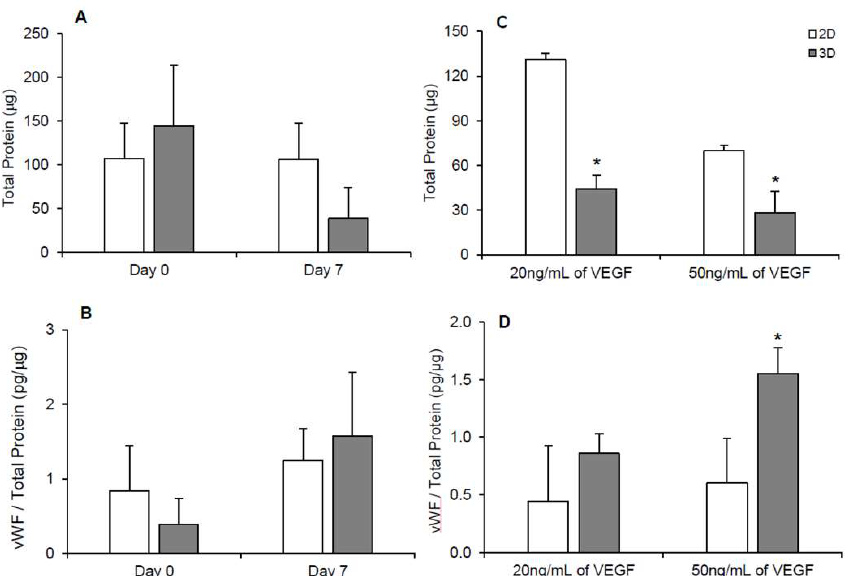
Figure 4. ( A ) Total protein content and ( B ) normalized vWF levels (vWF/total protein) of cells cultured in the scaffold-free 2D and 3D conditions without any additional VEGF supplementation on days 0 and 7. ( C ) Total protein content and ( D ) normalized vWF levels (vWF/total protein) of cells cultured in the scaffold-free 2D and 3D conditions on day 7 with the addition of VEGF. Bars show the average + upper 95% confidence interval. Statistical analysis performed by ANOVA. * indicates p ≤ 0.05. n ≥ 7.